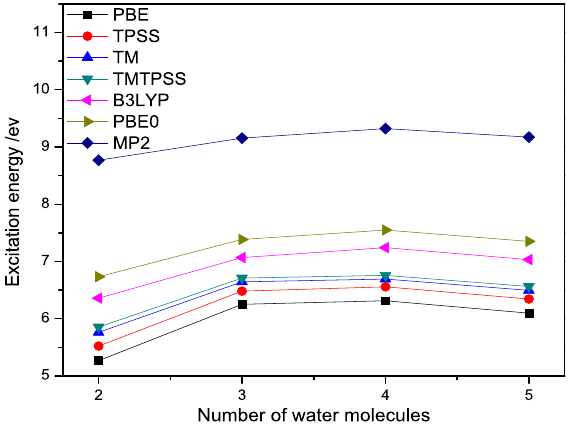
Figure 3. The lowest excitation energy (eV) of (H 2 O) n ( n = 2–5) calculated with different methods at 6-311++G(3 df ,3 pd ) basis